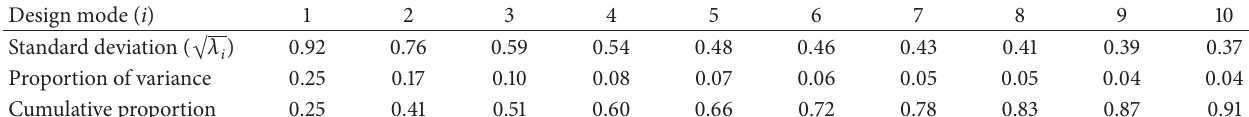
Table 1: Summary of running PCA on a MOKP nondominated solution set.